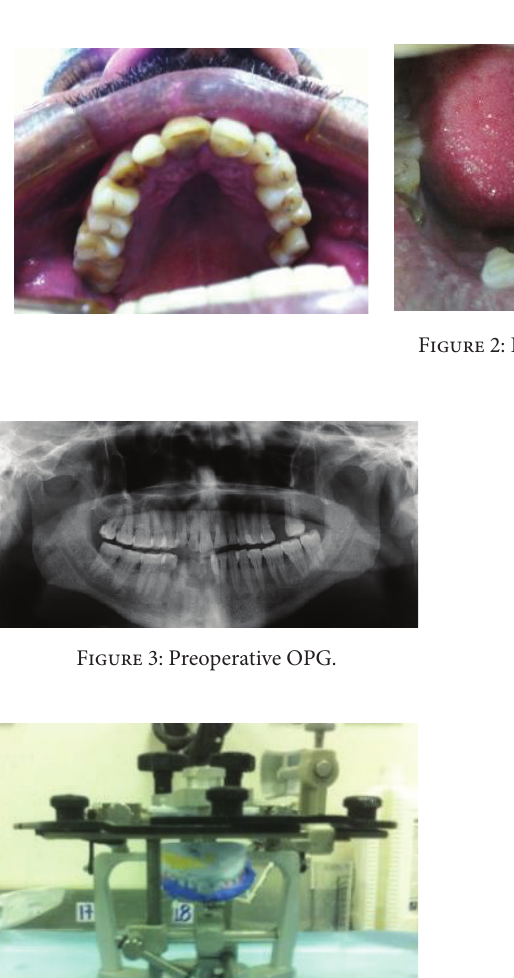
normal anatomy of glenoid fossa (Figure 3).